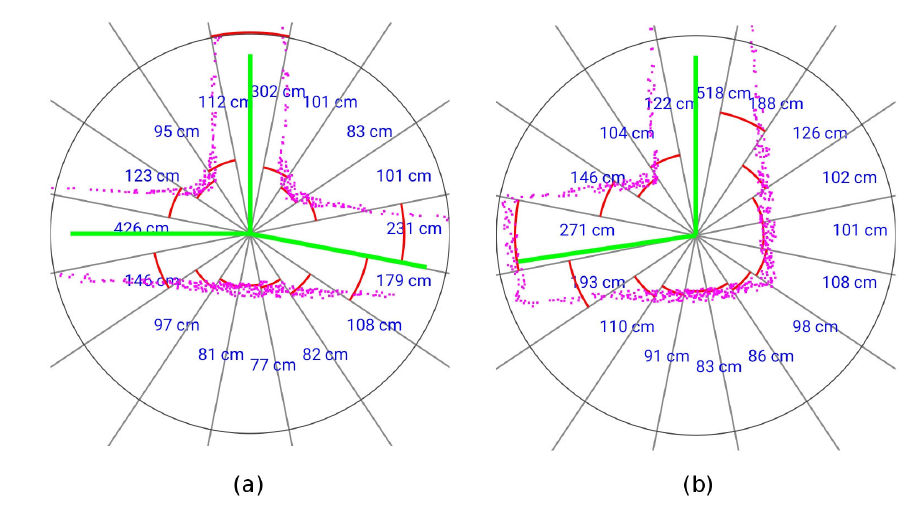
Figure 4. Scan processing result. ( a ) Three-way intersection. ( b ) Tunnel